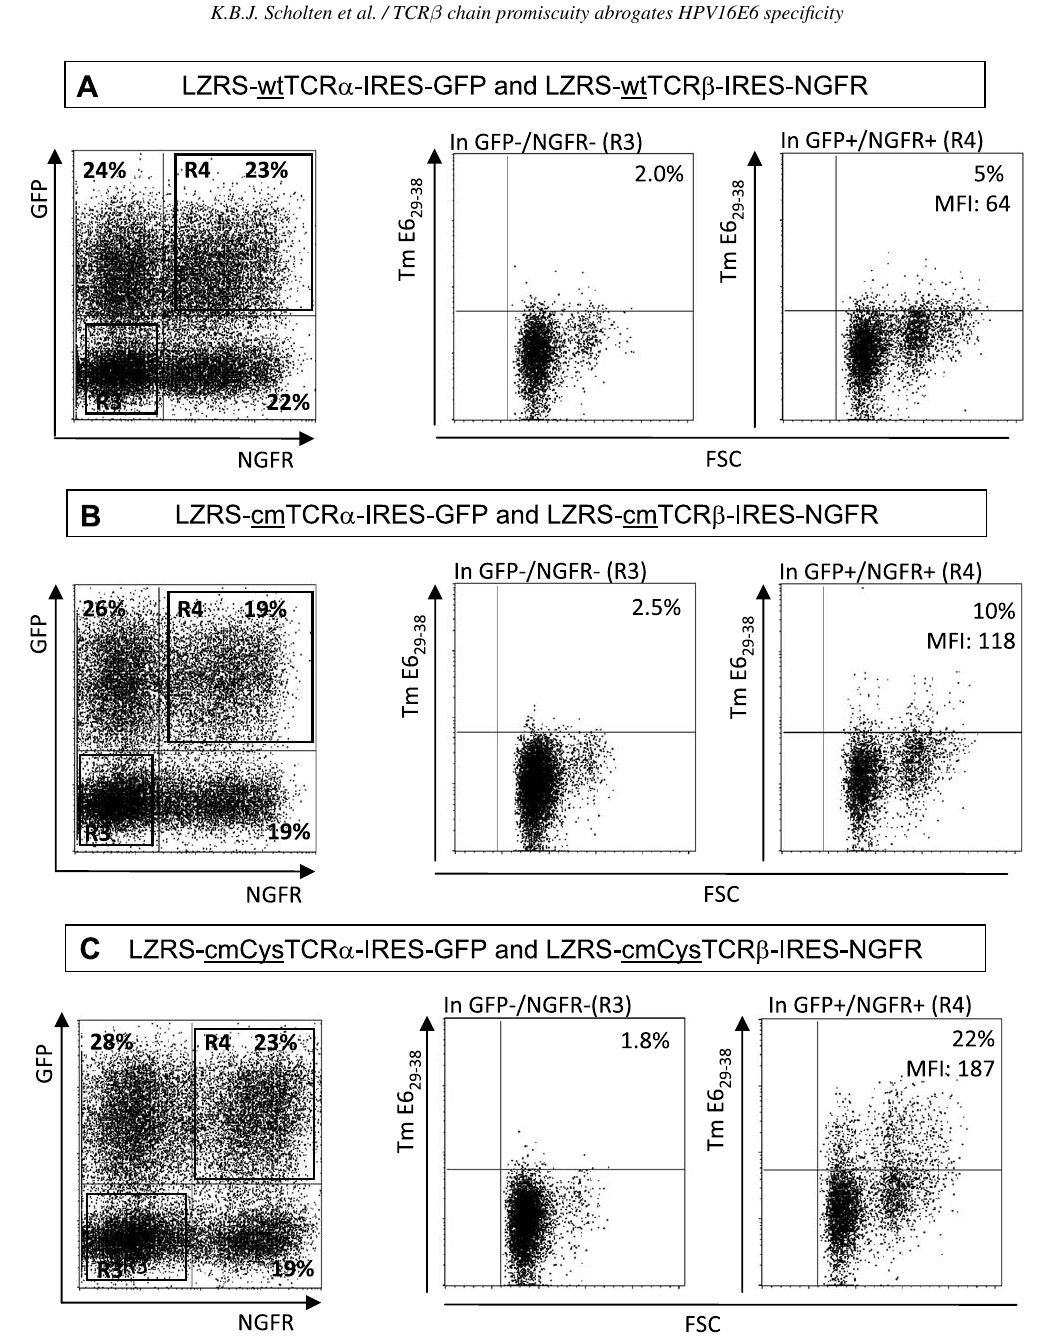
Fig. 3. Tetramer analysis of CD8 + T cells after transduction with wt, cm or cmCyc 7E7-TCR encoding retroviruses. Healthy donor derived CD8 + T cells were transduced with TCR α -I-GFP and TCR β -I-NGFR encoding retroviruses. Tetramer analysis was performed on T cells with the wt (A), cm (B) and cmCys (C) 7E7-TCR in gate R3 (GFP − /NGFR − ) and gate R4 (GFP − /NGFR + ). Data are representative for 4 different donors